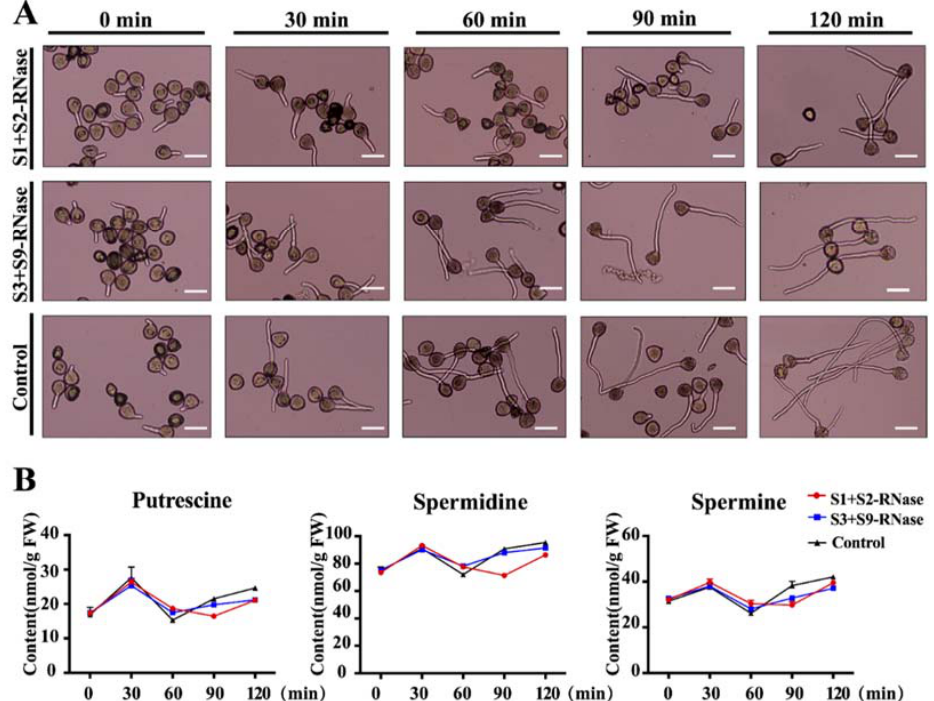
Figure 1. Effects of self-S-RNase on pollen tube length and polyamine contents in pollen tubes. ( A ) After hydration, the germination status of the pollen tube was observed at 0, 30 min, 60 min, 90 min, 120 min after self- and non-self-S-RNase treatment, the control represents the untreated pollen tubes, and the scale bar represents 15 µ m. ( B ) The content of putrescine, spermidine, and spermine: self-S-RNase, non-self S-RNase and control. Values are means of three biological